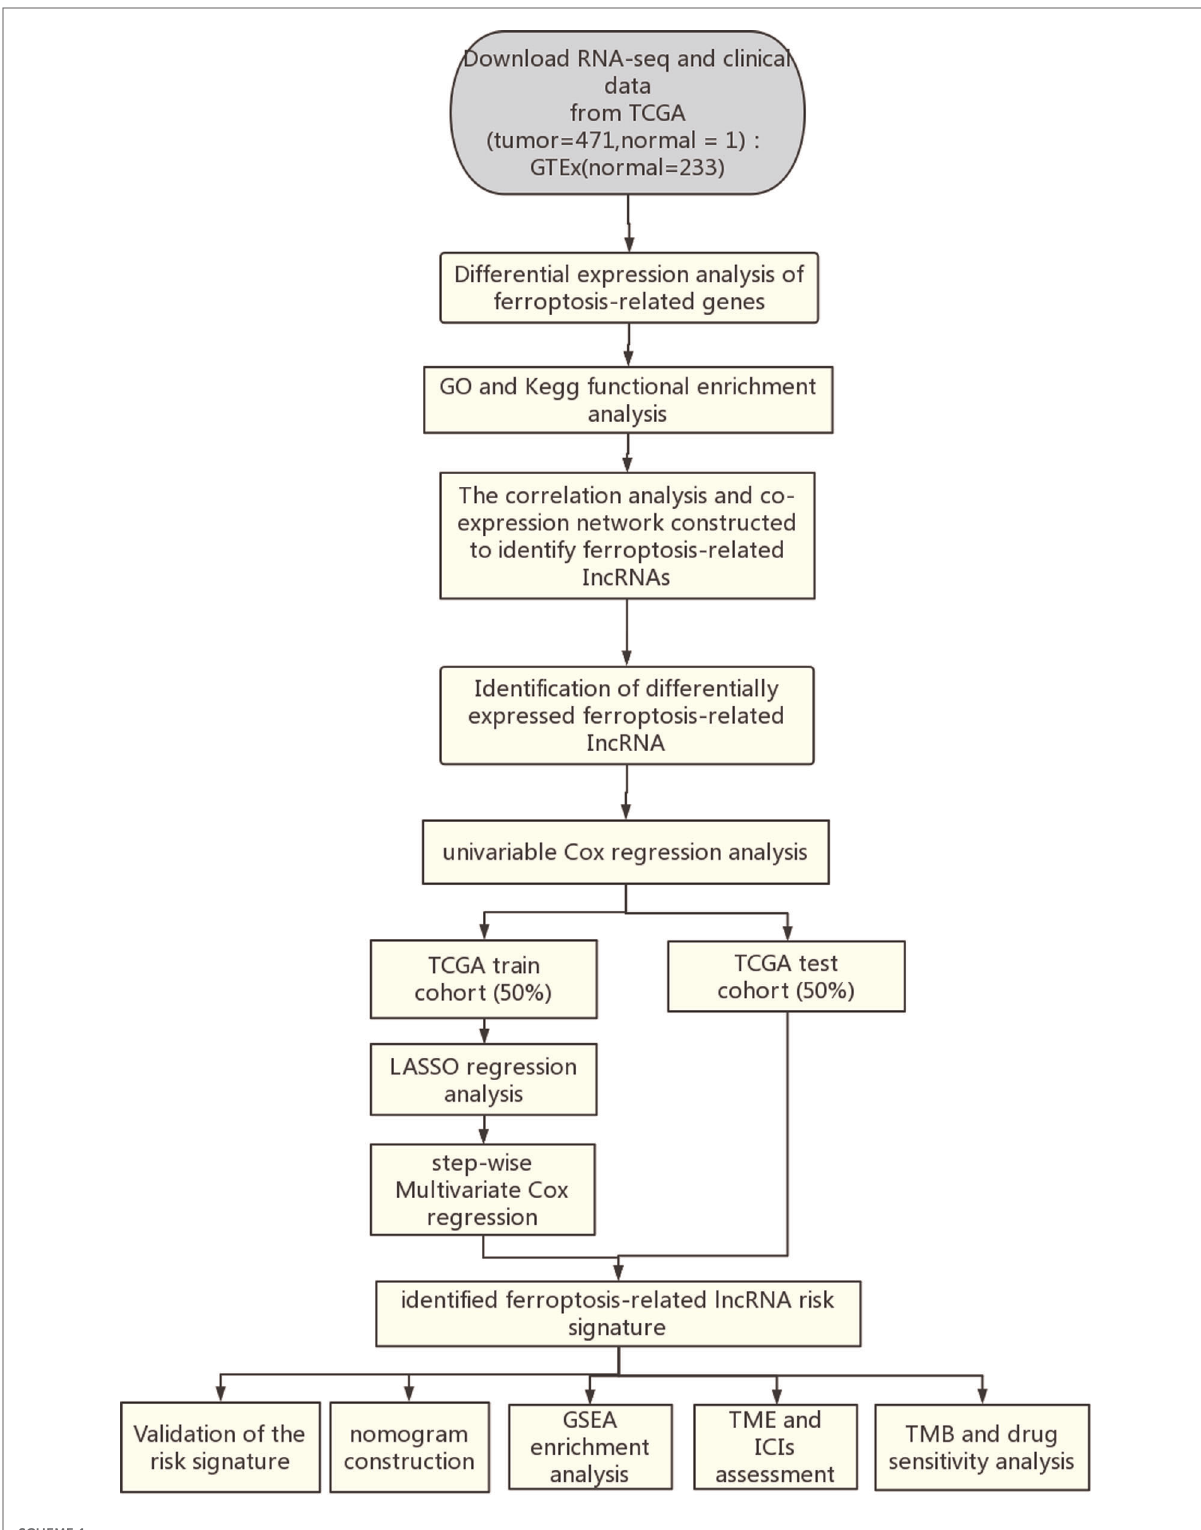
SCHEME 1 Flowchart of the analysis